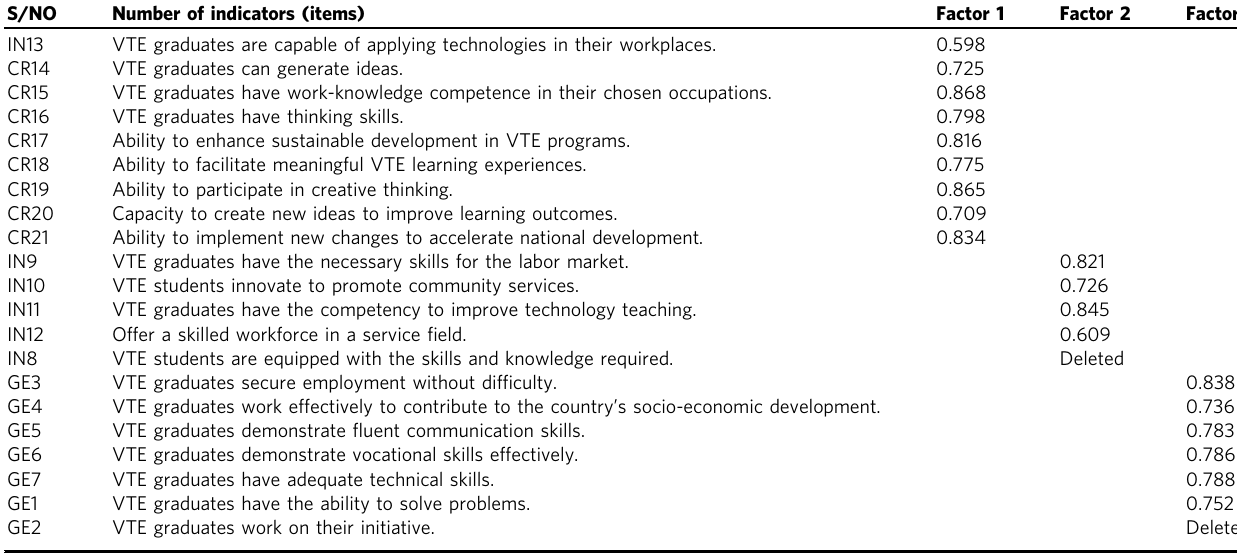
Table 10 Rotated component matrix of output QA factor structures and loadings. S/NO Number of indicators (items)